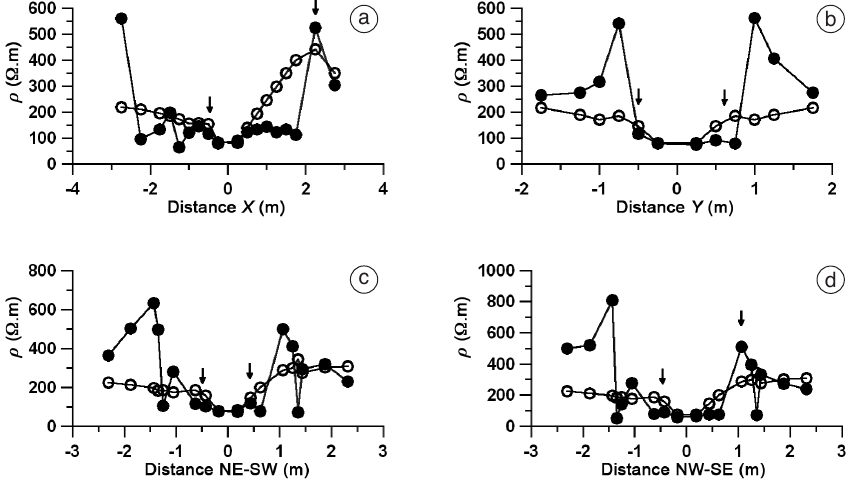
Fig. 8a-d. Forward 3D modelling from the results of the excavation. a) Central profile in X direction; b) cen- tral profile in Y direction; c) The NE-SW profile and d) The NW-SE profile. Data are represented by solid sym- bols and model response by open symbols. Arrows denote the approximate position of the walls of the